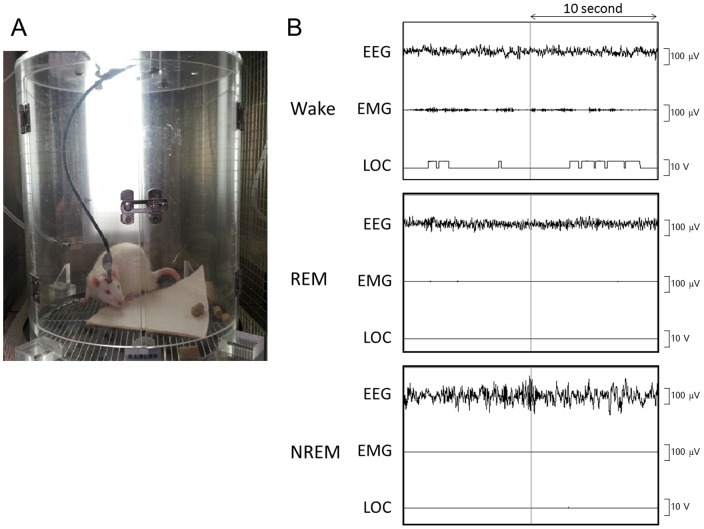
Polygraphic recordings used in this study.(A) Polygraphic system including EEG, EMG, and LOC in a sound-proof recording gage. (B) Typical EEG, EMG, and LOC of wake, REM sleep, and NREM sleep. EEG, electroencephalograph; EMG, electromyography; LOC, locomotor; NREM, nonrapid eye movement; REM, rapid eye movement.